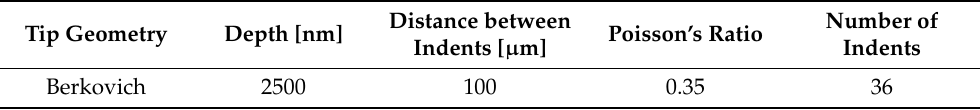
Table 2. Testing parameters of Nanoindenter